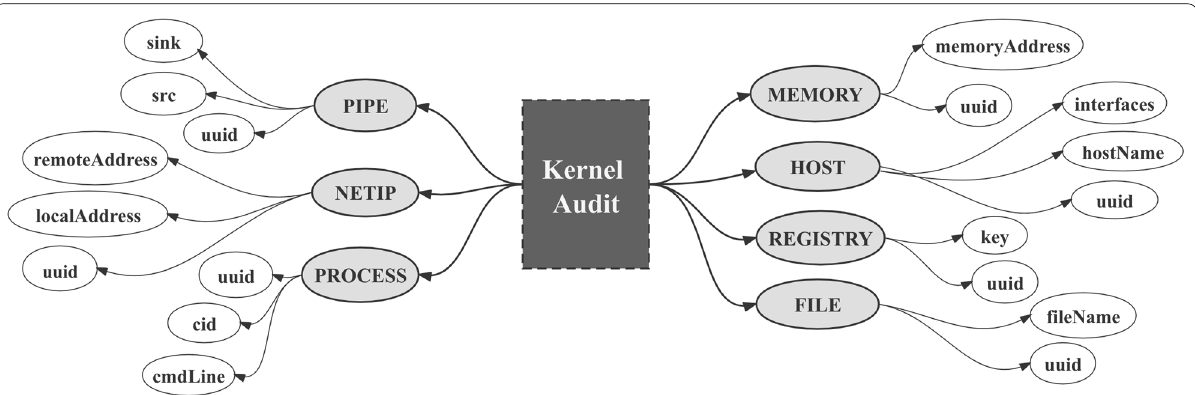
Fig. 2 Ontology of kernel audit for threat